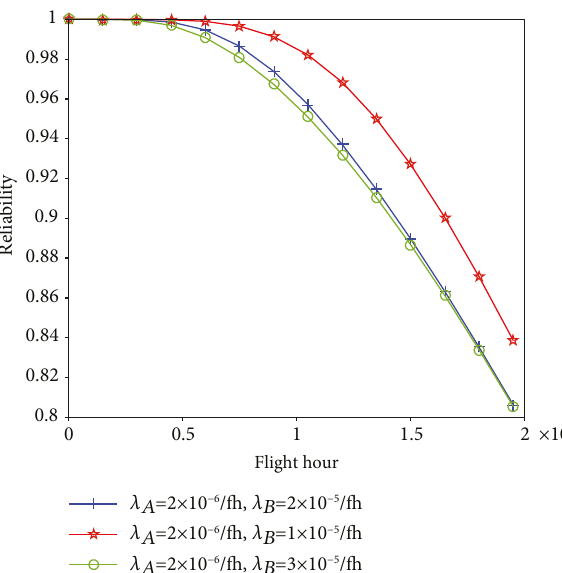
Figure 7: Reliability of the system for di ff erent λ